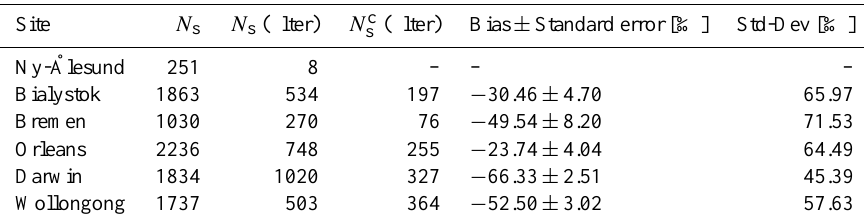
Fig. 8. δ D retrieved from GOSAT over six TCCON sites between April 2009 and June 2011. Small grey symbols show the cloud-free retrievals, small red squares cloud-free, quality-filtered retrievals and large red circles the daily averages of quality-filtered retrievals (open symbol indicates that only a single data point is used). TCCON retrievals are shown in green. Here, we have used a spatial co-location criterion of ± 5 ◦ and ± 3h for the temporal coincidence criterion. Table 3. Same as Table 2 but the additional cirrus cloud filter has been included in the quality-filter. The data are only given for the a spatial co-location criterion of ± 5 ◦